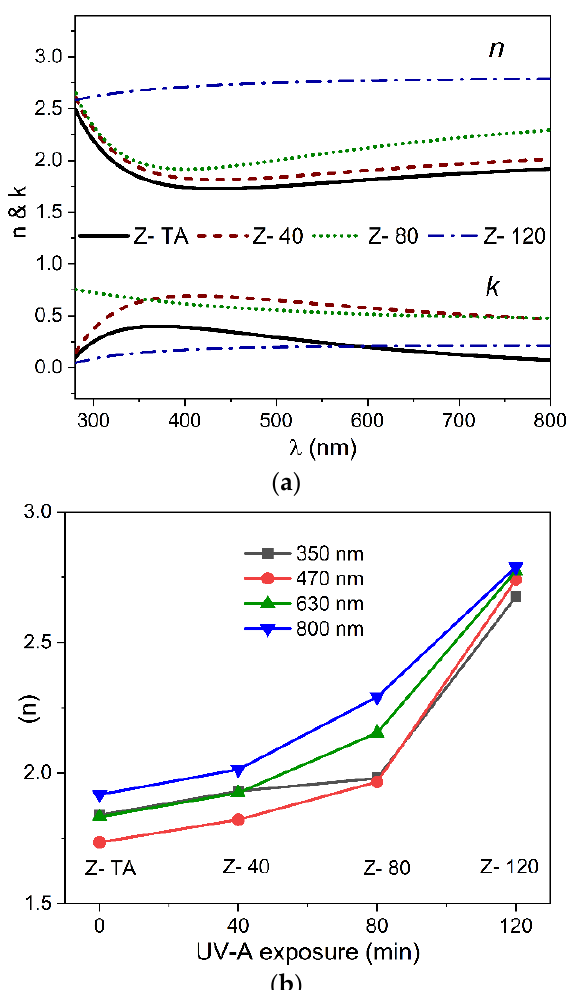
Figure 5. The dispersion curves of n and k ( a ) plotted against wavelength range (280–800 nm) for thermally treated and UV-A treated ZrO 2 films. ( b ) The values n acquired at four different wavelengths shown are plotted against UV-A exposure time.